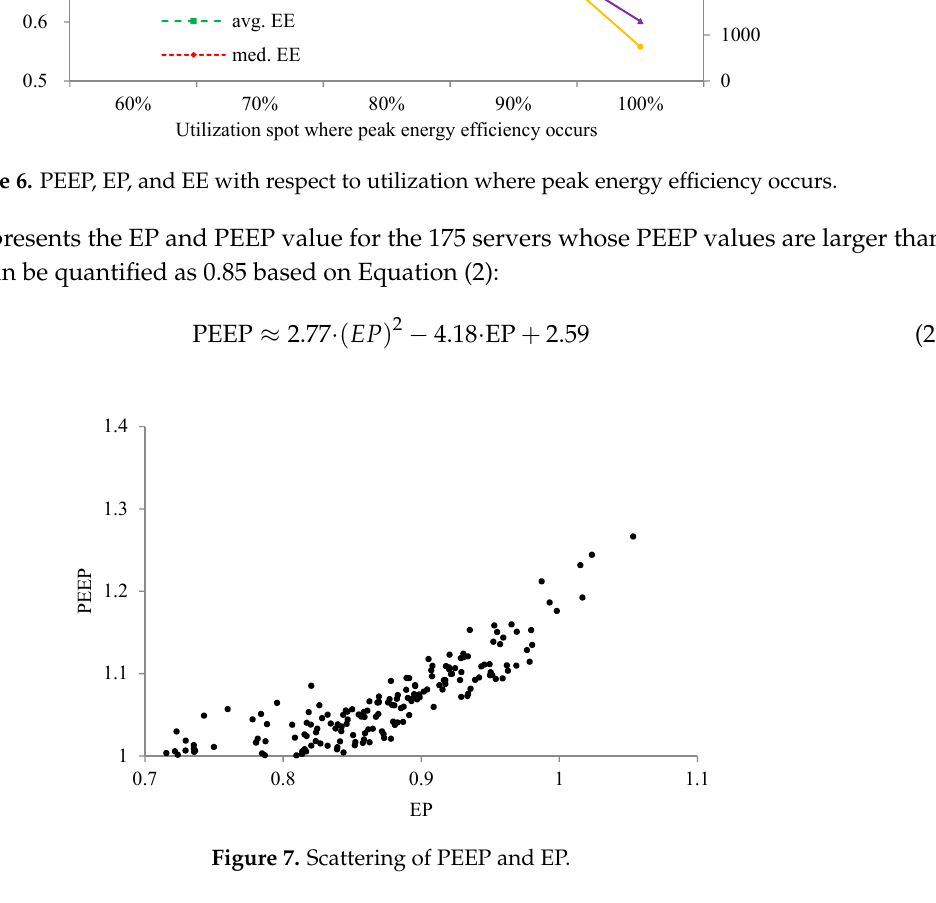
Figure 7. Scattering of PEEP and EP.